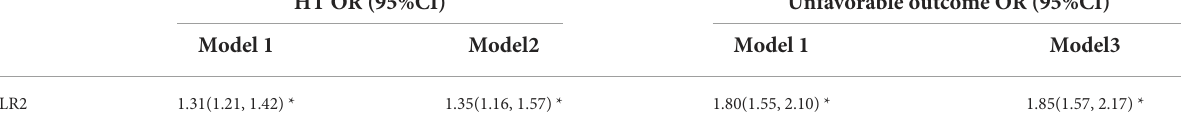
TABLE 3 Associations of NLR2 with HT and unfavorable